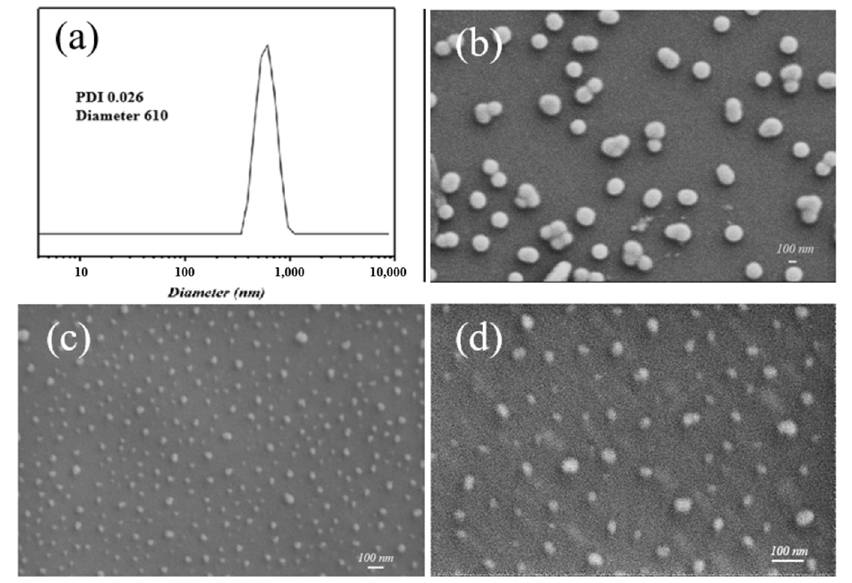
Figure 2. DLS diagram ( a ) and SEM image ( b – d ) of VPA-microgel ( a , b ) and micro-container ( c , d